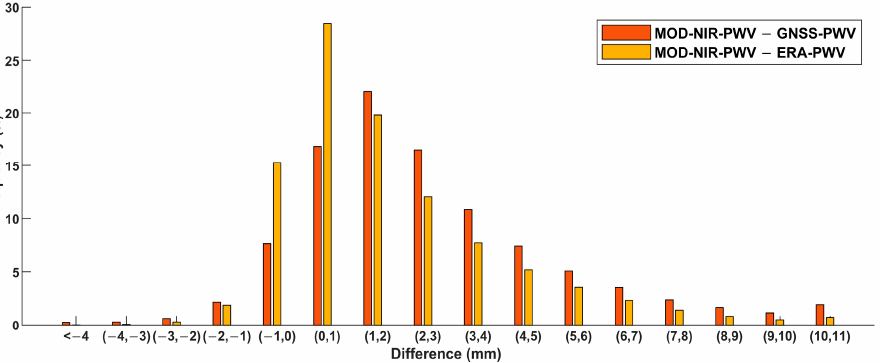
Figure 7. Distribution of the differences (in millimeters) between GNSS-PWV, ERA-PWV, and MOD-NIR-PWV in the six-year period studied from 2013 to 2018 over China.